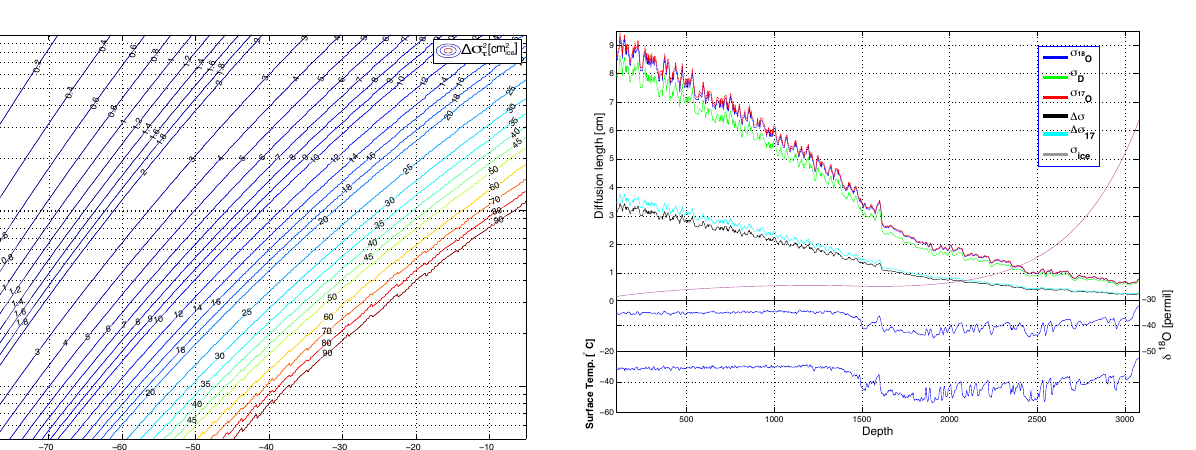
Fig. 2. Modelled differential diffusion length at the pore close-off depending on accumulation and surface temperature.